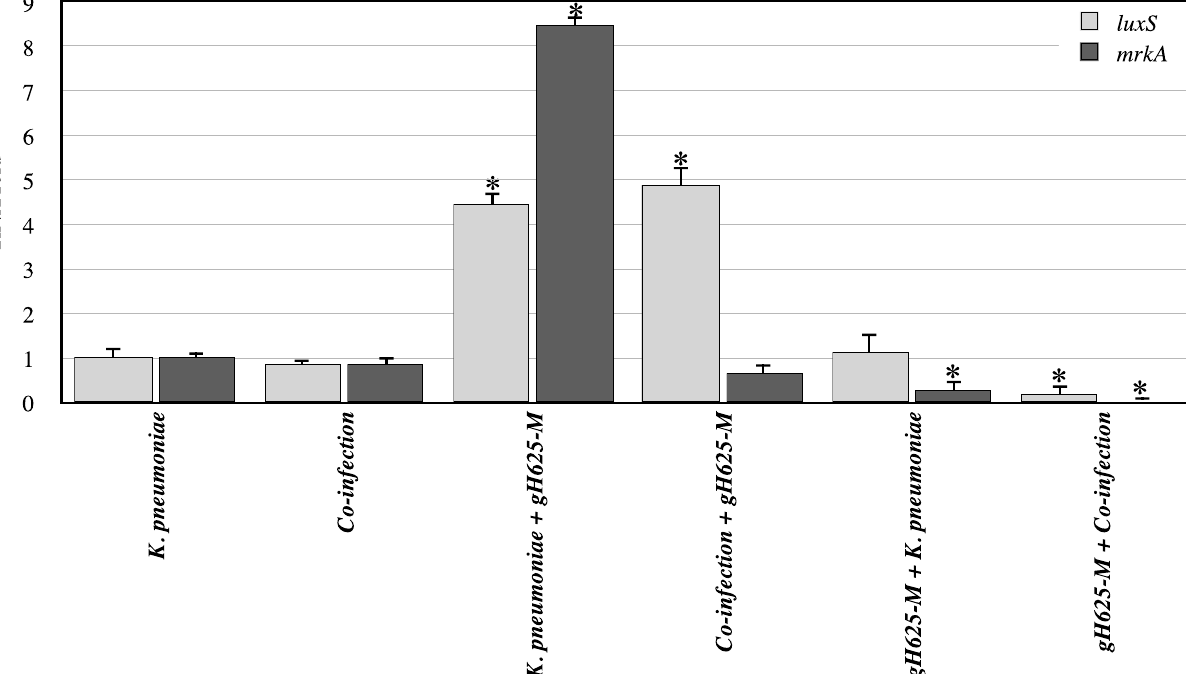
Figure 8. Relative mRNA expression levels of K. pneumoniae virulence genes ( luxS and mrkA ) in G. mellonella larvae at 24 h, measured using real-time PCR analysis and calculated by the 2 ( − ∆∆ C(T)) method. 16S gene was used as housekeeping. Each sample was tested and run in duplicate. No-template controls were included. * asterisk indicates that the difference vs. expression of larvae treated with K. pneumoniae only is statistically significant (Wilcoxon two group test p < 0.05). Error bars represent the SEM.